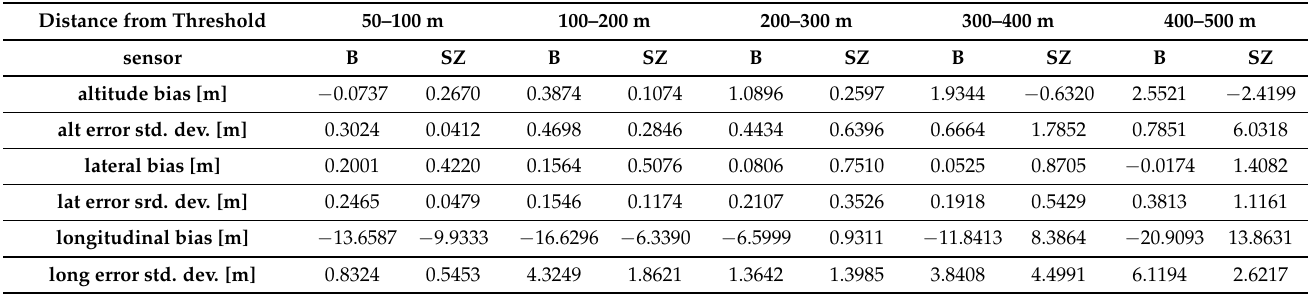
Table 2. Bias and standard deviation of navigation data in different distance intervals at Wiener Neustadt/Ost (B: Braun- schweig SZ: